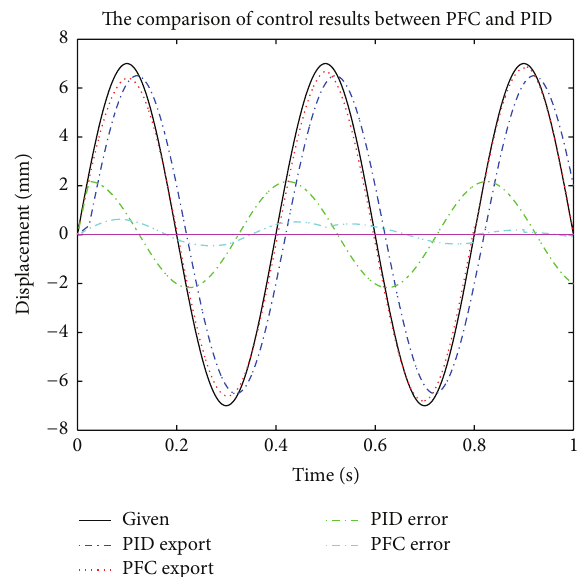
Figure 6: Comparison of PFC and PID control simulation